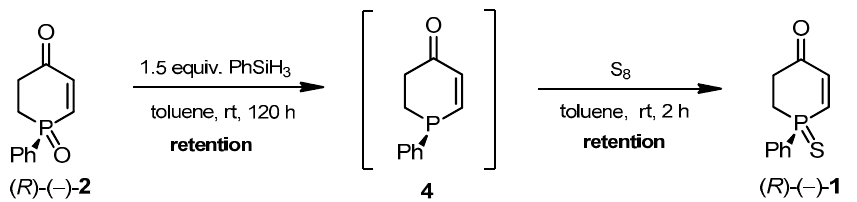
( b ) Figure 12. ( a ) Liberation of the enantiomers of phosphin-2-en-4-one 2 on silica gel columns; ( b ) cop- ies of CSP-HPLC traces of ( R )- 2 and (S)- 2 (CHIRALCEL-OD-H). 2.5. Determination of the Absolute Configuration of 1 -Phenylphosphin- 2 -en- 4 -one 1 -sulfide ( 1 ) by Chemical Correlation